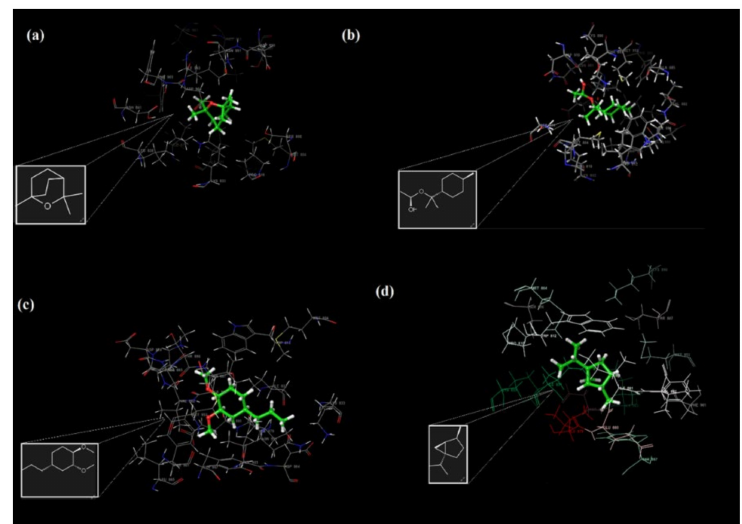
Figure 8. The active binding residues in the PI3K/mTOR target receptor (PDB 4FA6) and four docked major ingredients of LNEO: 1,8-cineole ( a ), α -terpinyl acetate ( b ), methyleugenol ( c ), and sabinene ( d ).